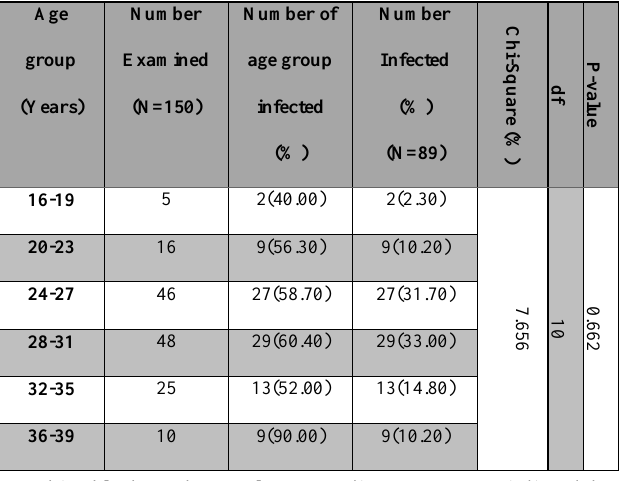
Table 1. Prevalence of malaria in conjunction with age among gravid females attending antenatal clinic at two Maternity Centres in Atani, Anambra State, South-eastern